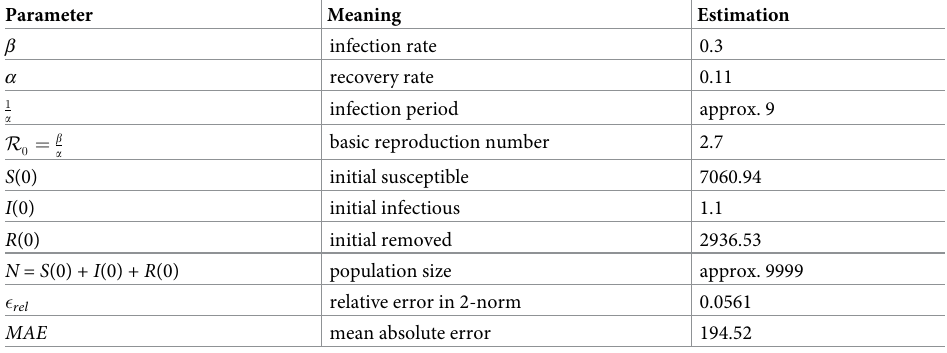
Table 3. Parameters and parameter estimations of the best fit basic SIR